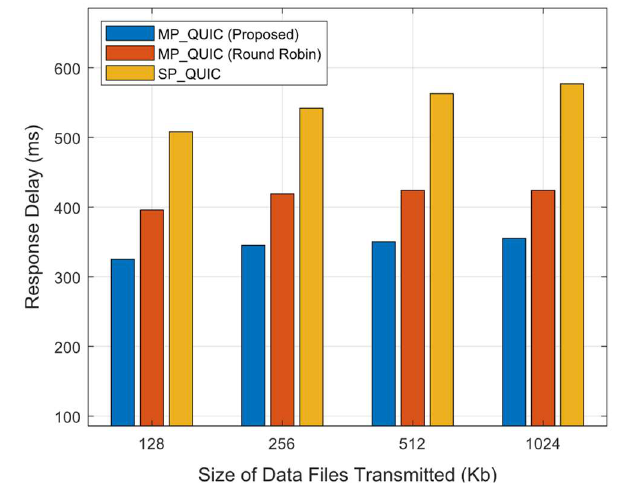
Figure 5. Comparison of response delays for different sizes of data files transmitted.